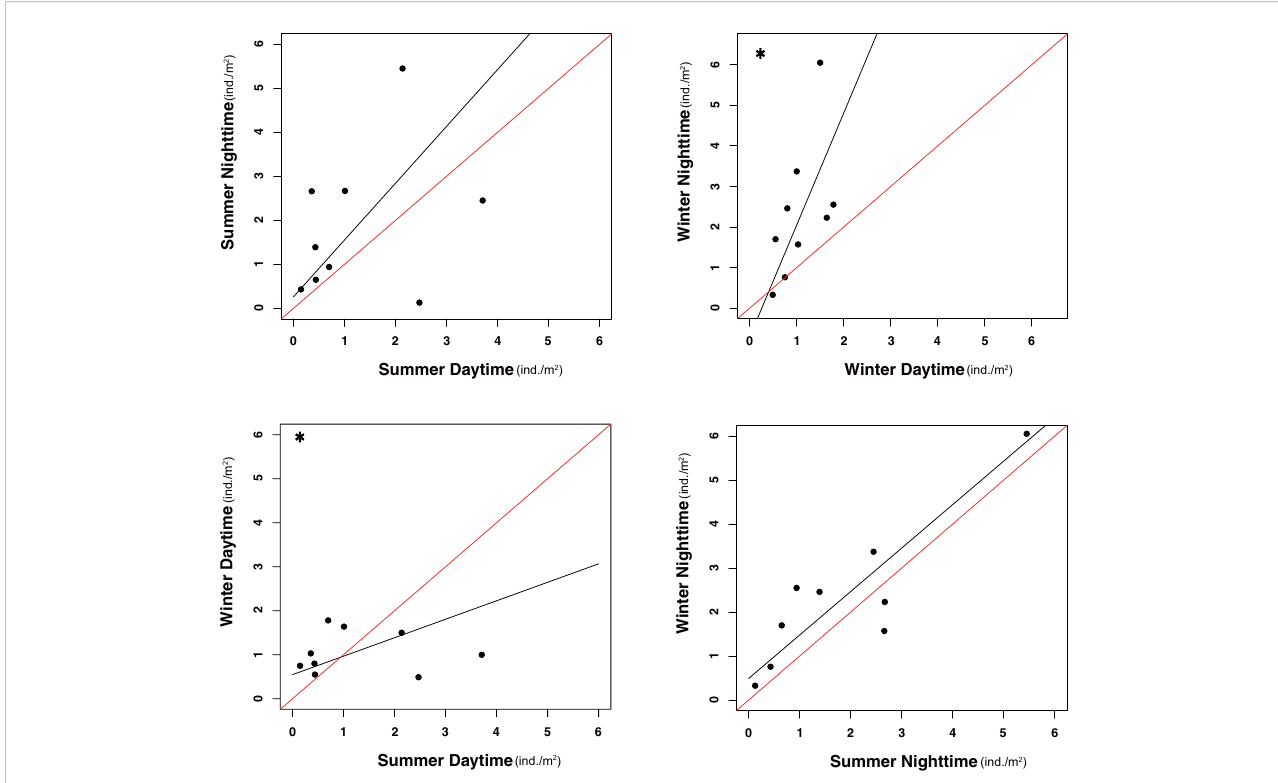
FIGURE 4 Linear relationship between seasonal and diel results for mean density in nine areas. Asterisks in the upper left corner indicates signi fi cant correlations (p < 0.05). The red line represents the 1:1 line, and the black line the relationship estimated by the SMA (N = 9).